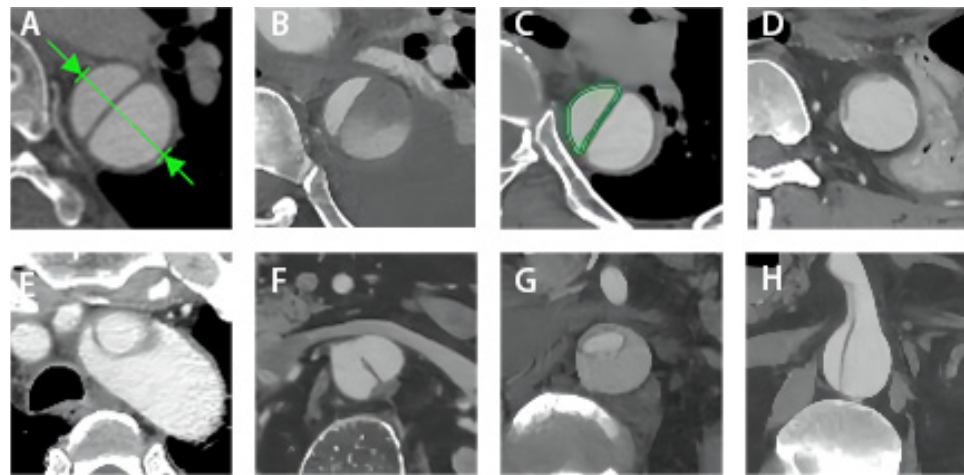
Figure 2. Observation of eight morphologic features: ( A ) measurement of diameter; ( B ) partial thrombosis of the FL; ( C ) TL; ( D ) TL compression; ( E ) dissection extends to the aortic arch; ( F ) untreated tear; ( G ) annular tear; ( H ) dissection extends to abdominal branches. FL, false lumen; TL, true lumen.